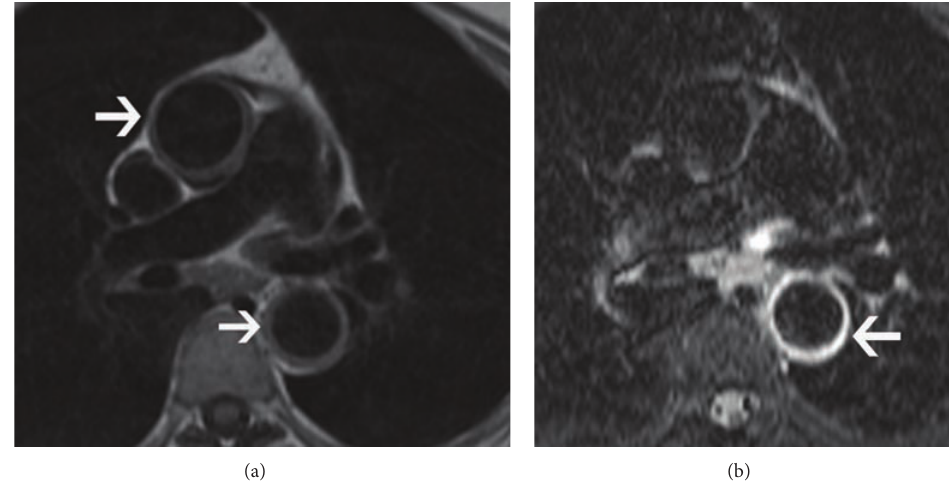
Figure 19: Giant cell arteritis—(a) axial T2-weighted double inversion recovery black blood image in a 68-year-old female patient with giant cell arteritis shows mild circumferential thickening of the ascending and descending aorta (arrow). (b) T2-weighted triple inversion recovery black blood image in the same patient with giant cell arteritis shows very minimal high signal of the descending aorta (arrow), which is consistent with mild active